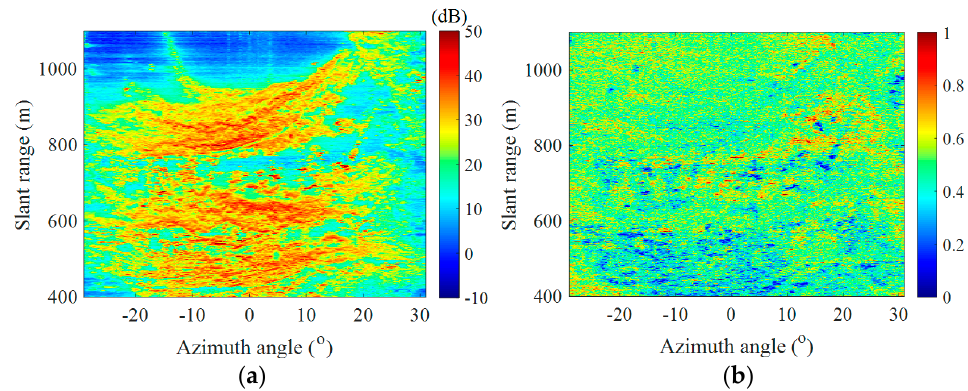
Figure 9. ( a ) Signal-to-noise ratio (SNR) map of the monitoring area; ( b ) ADI map calculated with the first 30 images.